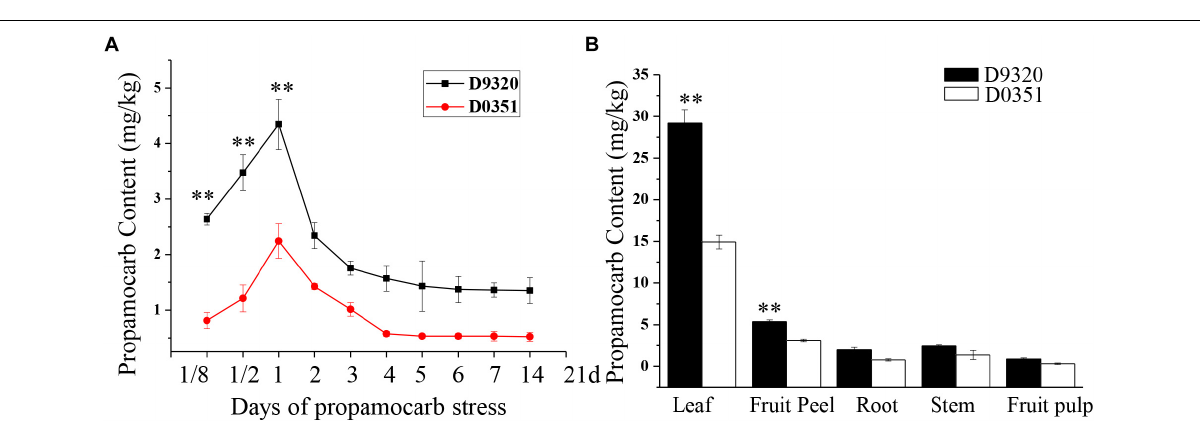
FIGURE 2 | Propamocarb residues in cucumbers. (A) Time course of propamocarb residue in cucumber fruit peels of “D0351” and “D9320” plants. (B) Propamocarb residues in leaf, stem, root, fruit peel, and fruit pulp of “‘D0351” and “D9320.” Data are means ( ± SE) of three independent experiments with three replicates for each. Statistically significant differences were determined by Student’s t -test ( p <